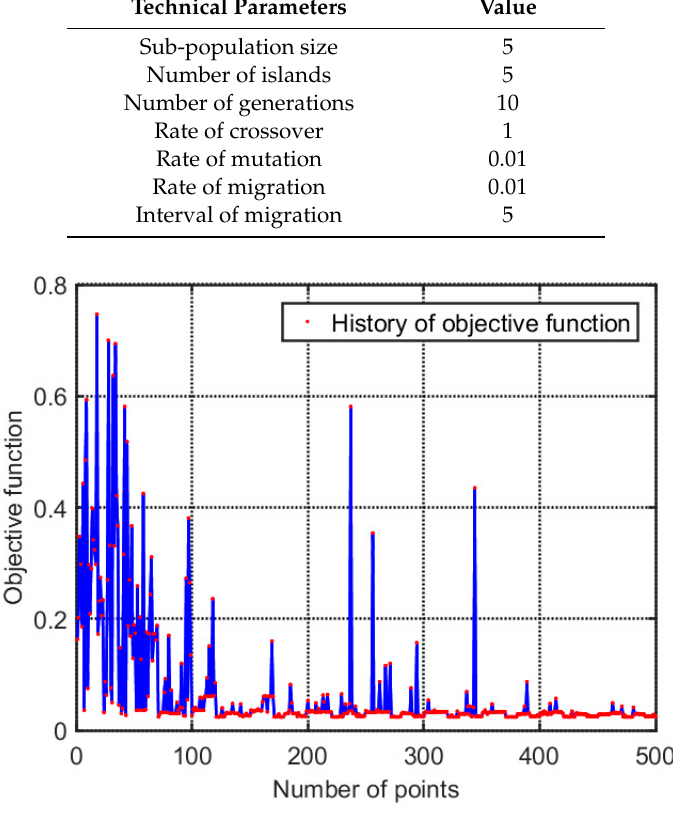
Figure 11. The history of minimizing the objective function.